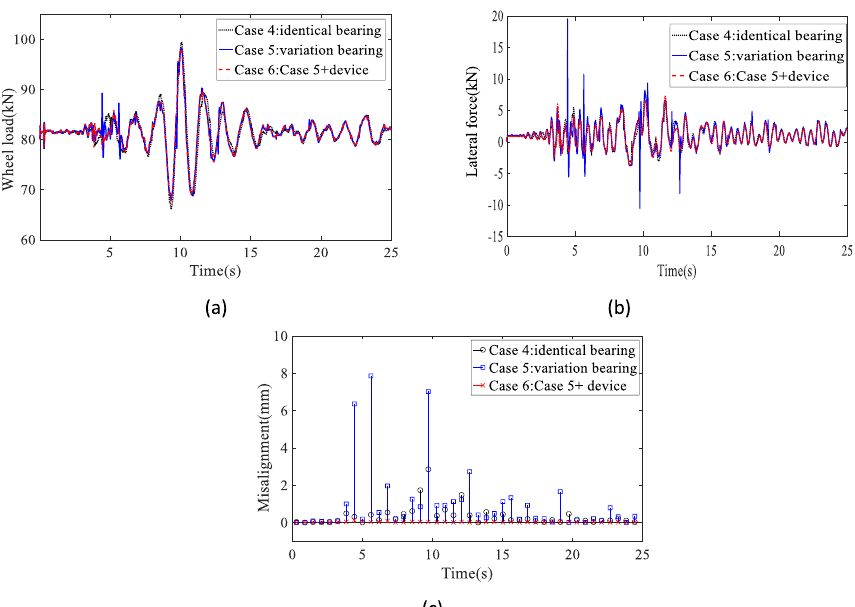
Fig. 19 Wheel-rail forces for No.1 ground motion input: a wheel load; b lateral wheel-rail force; and c maximum misalignment beneath wheel